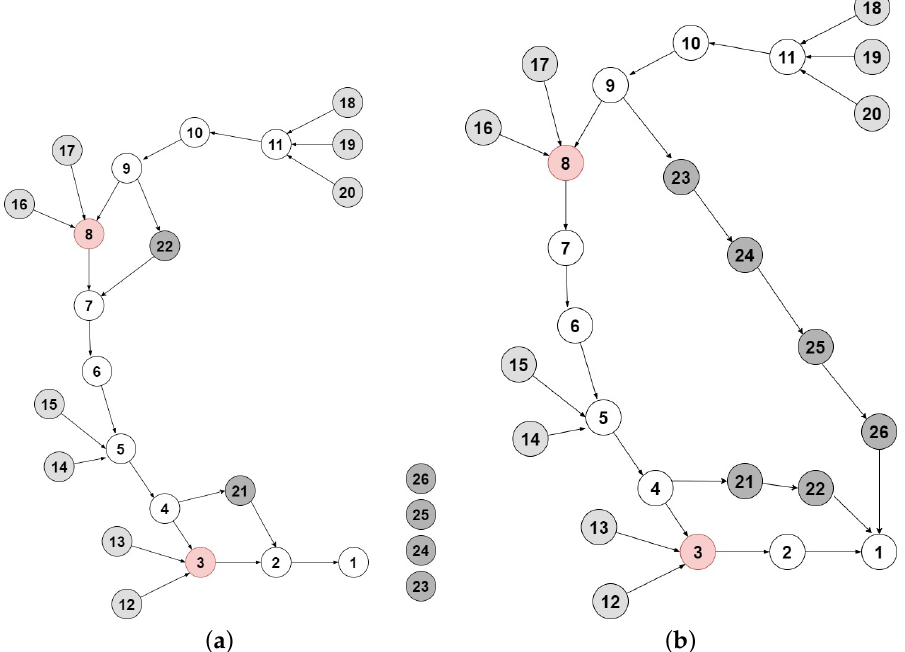
Figure 5. Execution example of the NPA variations. ( a ) Dynamic MobileCC Execution of the Example, ( b ) Direct Path MobileCC Execution of the